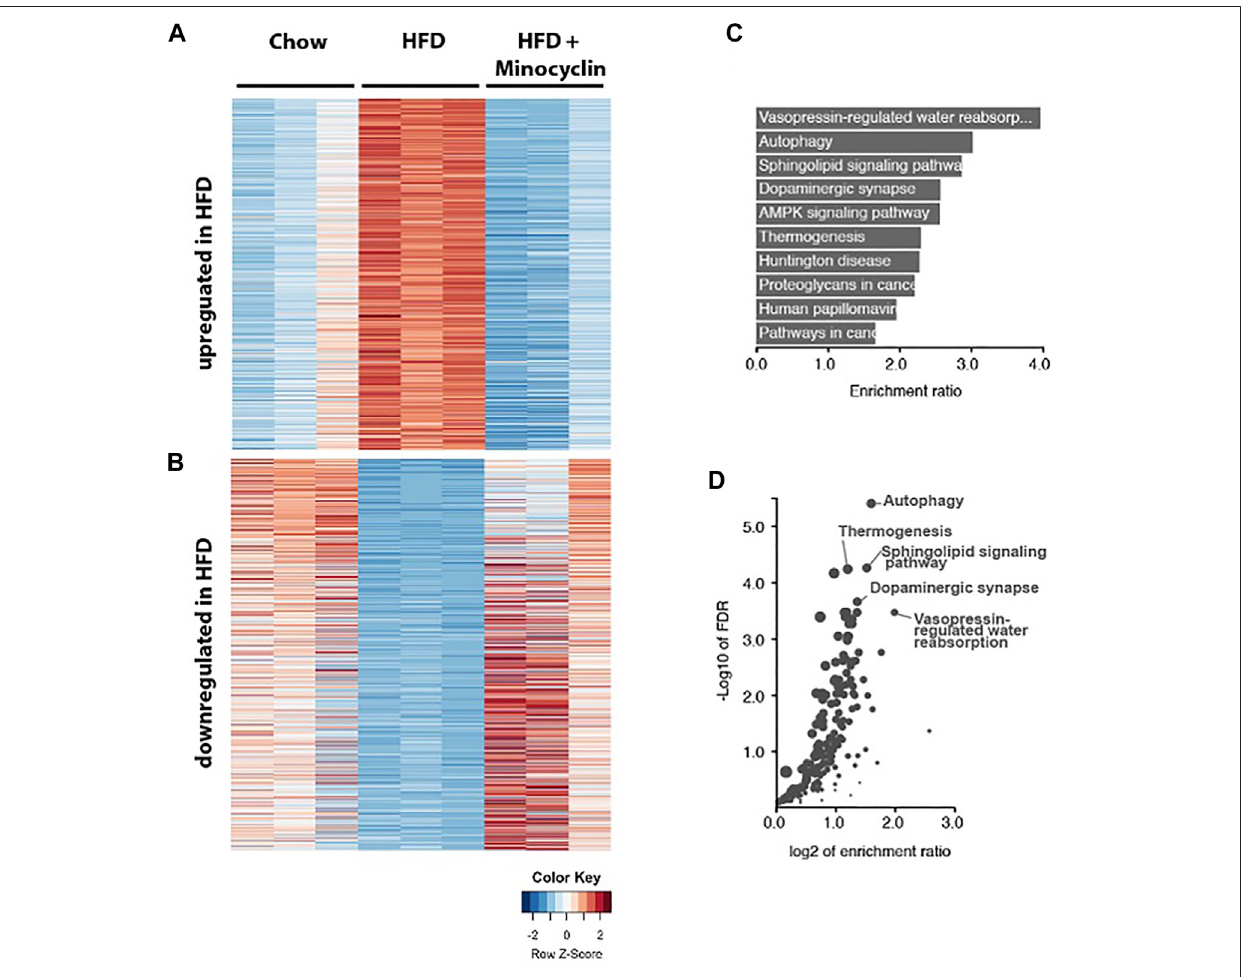
FIGURE 7 | RNA sequencing of PVN identi fi es genes associated with HFD that are rescued by minocycline treatment. (A,B) Heat map showing the HFD upregulated and downregulatedgenescompared tocontrol chow dietand HFD+minocycline treatment. Columns are biological replicates, rows aregeneswithcolored scaled rowz-scoreoflog2(cpm+1)geneexpression valuesforeach sample. (C – D) PathwayanalysisoftheHFDaltered genesetinAwithenrichmentratio (C) andFDR values (D) identi fi es autophagy as one of the highest ranked and signi fi cant pathways in the PVN.